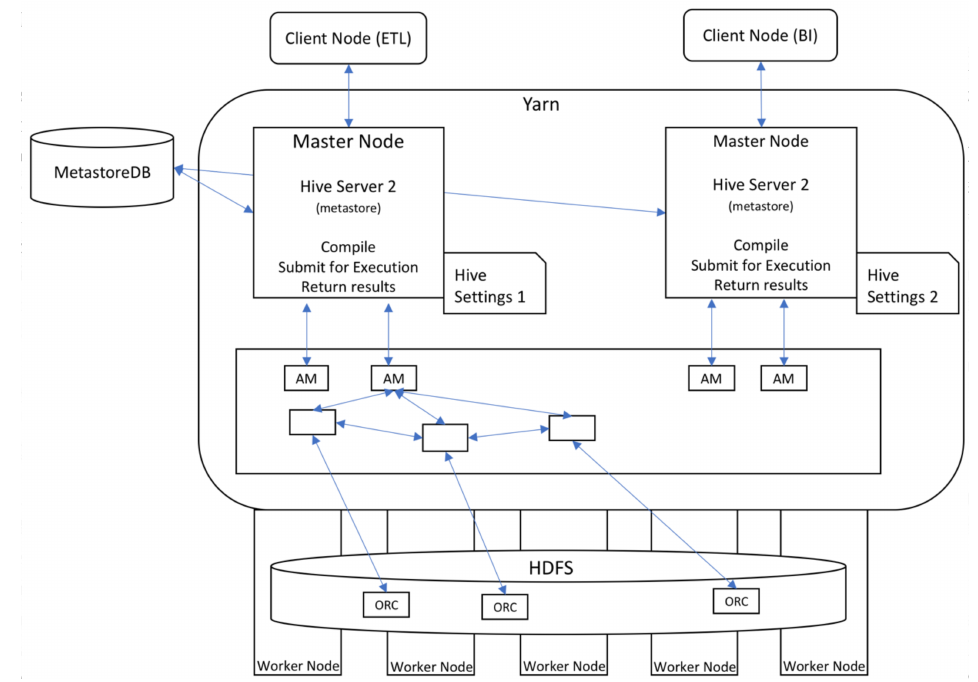
Figure 3. The architecture of Hive.